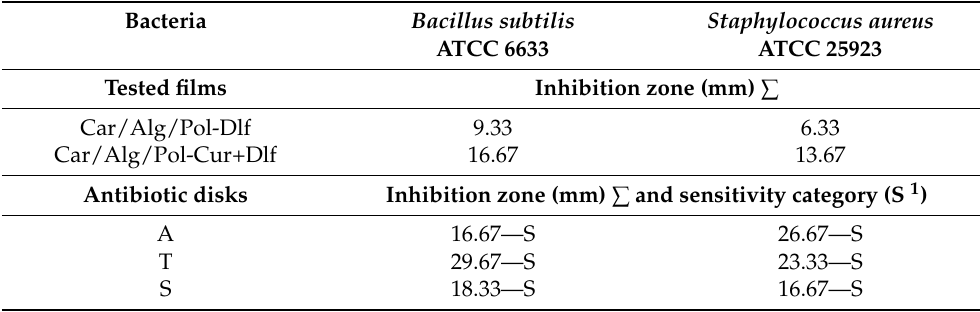
Table 5. Results of susceptibility of tested Gram-positive bacteria to films and antibiotics discs. Staphylococcus aureus Bacteria Bacillus subtilis ATCC 6633 ATCC 25923 Tested films Inhibition zone (mm) ∑ Car/Alg/Pol-Dlf 9.33 6.33 Antibiotic